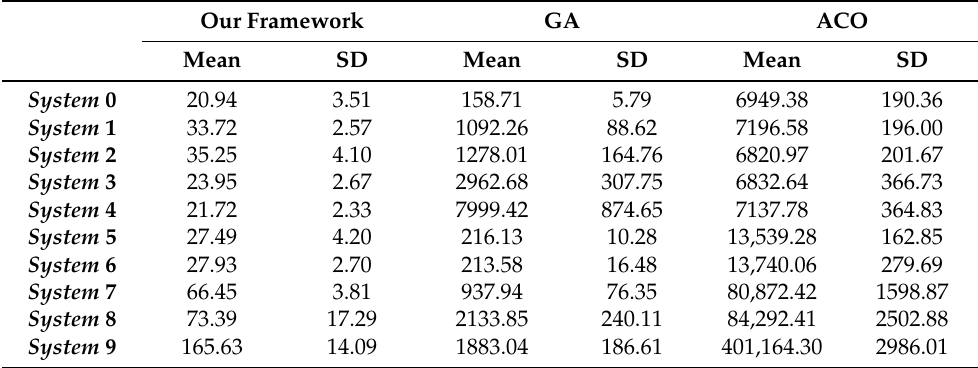
Table 4. The execution time results for our Framework, GA, and ACO (the unit is in seconds). SD stands for standard